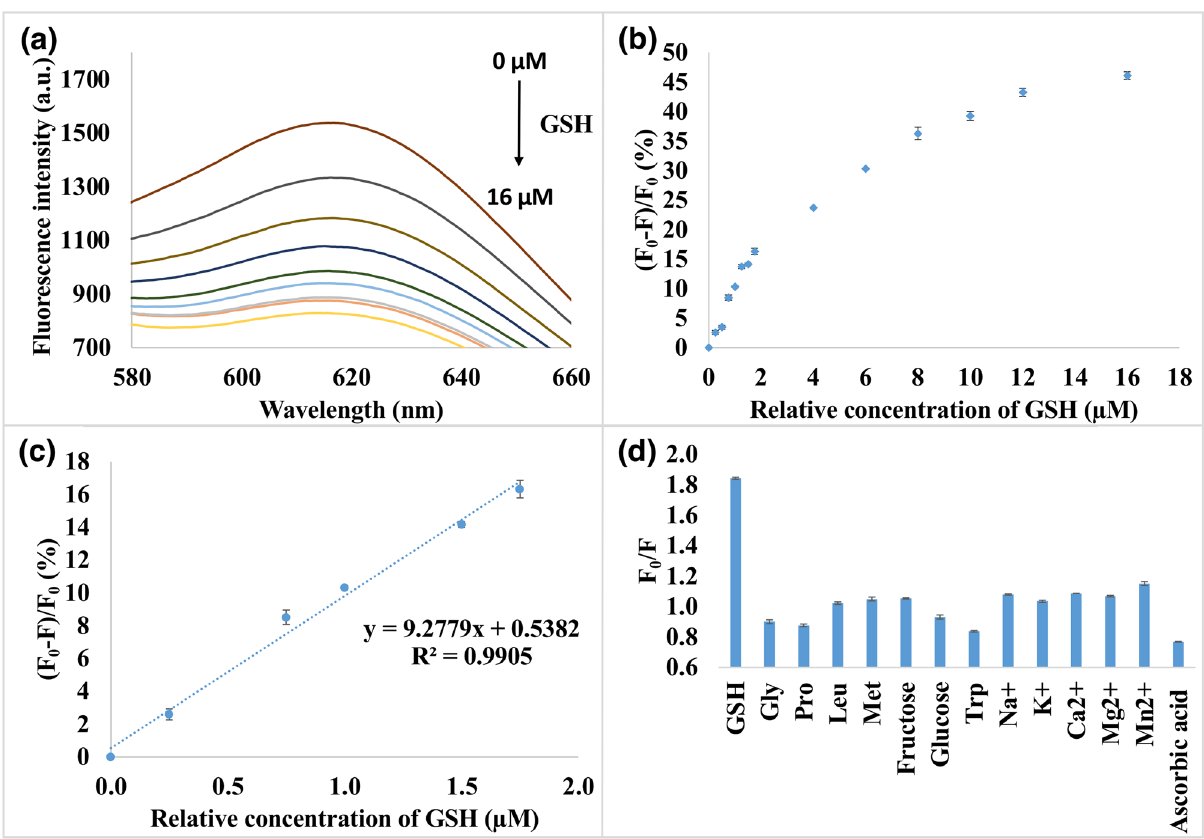
Figure 5. Sensitive and selective detection of GSH using FA-rGO-BSA/AuNCs. ( a ) Fluorescence intensity of FA-rGO- BSA/AuNCs by varying the concentrations of GSH. The relative concentrations of GSH were 0, 2, 4, 6, 8, 10, 12, 14 and 16 µg mL −1 at λ ex = 365 nm. ( b ) Relationship between the fluorescence quenching values (F 0 − F)/F 0 and the target concentrations. ( c ) Linear response of the fluorescence quenching values (F 0 − F)/F 0 to the concentration of GSH. Error bars are the standard deviation of three repetitive experiments. ( d ) Selective detection of 0.5 mM GSH in the presence of potentially interfering components. The concentrations of glycine, proline, leucine, methionine, fructose, glucose, tryptophan, NaCl, KCl, CaCl 2 , MgSO 4 and MnCl 2 ·4H 2 O were 5 mM. The concentration of ascorbic acid was 50 mM. F 0 and F are the fluorescence intensities of the sensing system in the absence and presence of GSH (or other potentially interfering chemicals), respectively. Error bars indicate the standard deviation of three independent